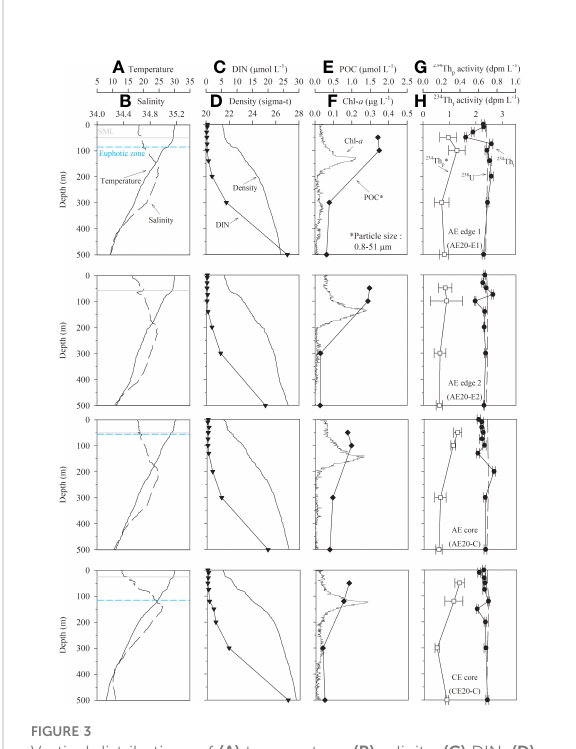
FIGURE 3 Vertical distributions of (A) temperature, (B) salinity, (C) DIN, (D) density, (E) POC, (F) Chl- a , (G) 234 Th p , and (H) 234 Th t at the edges, the core of an anticyclonic eddy, and the core of a cyclonic eddy in the tropical northwest Paci fi c in September 2020. The depths of SML (solid line) and euphotic zone (dashed line) are denoted. The euphotic zone at AE20-E2 were not shown because PAR data are not available. Particle samples were 0.8 – 51 µm in size.